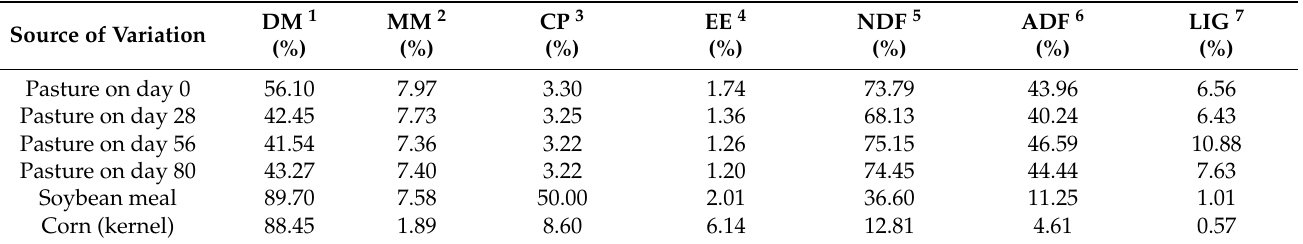
Table 1. Chemical composition of soybean meal, corn, and Masai grass on days 0, 28, 56, and 80 of the experimental